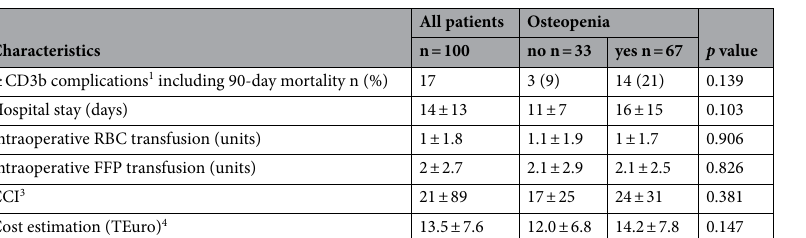
Table 2. Perioperative outcome. Values were given as mean ± standard deviation or absolute and relative frequencies (per cent). 1 Refers to Clavien et al. 26 3 Refers to Slankamenac et al. 27 4 Refers to Staiger et al. 29 . CD Clavien-Dindo classification, ICU intensive care unit, RBC red blood cell units, FFP fresh frozen plasma units, CCI Comprehensive Complication Index, TEuro thousand Euros.